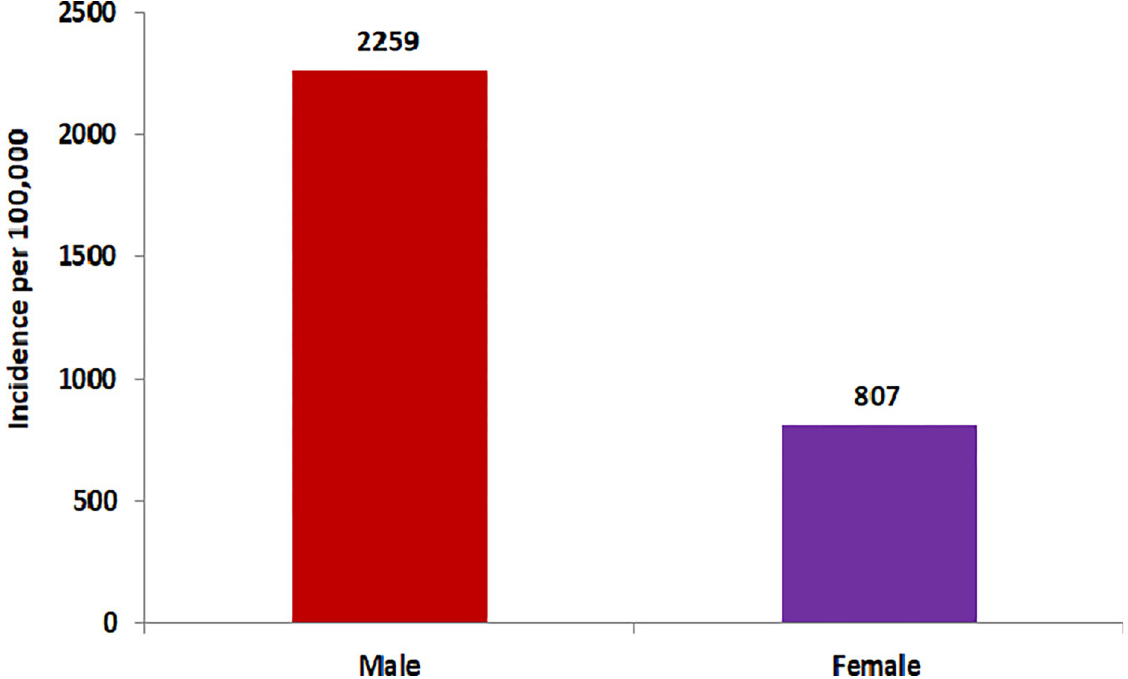
Fig 2. Incidence (smear and/or culture positive) of PTB by